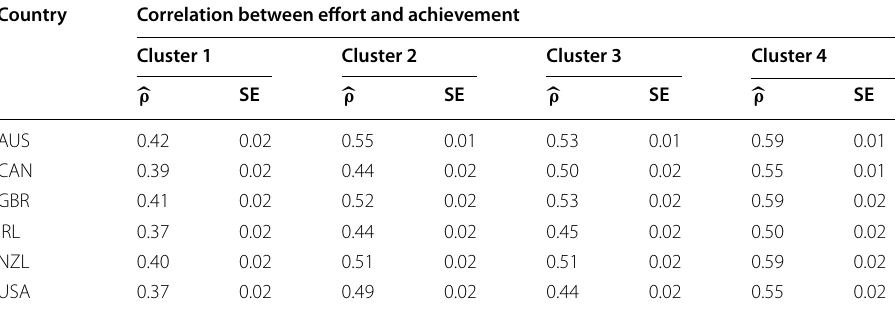
Table 7 Correlation between student test-taking effort and student achievement in science